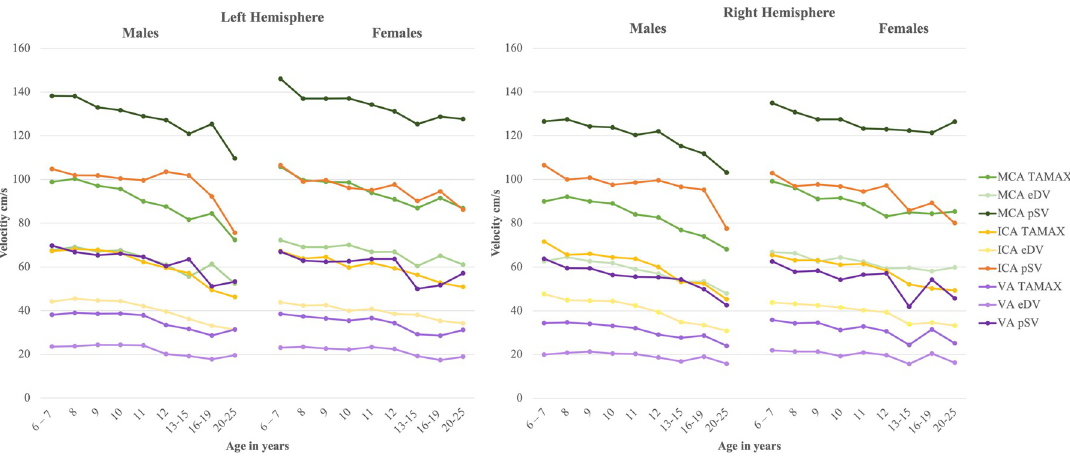
Fig 3. Velocities as a function of age, gender, blood vessel and hemisphere for males and females. MCA = middle cerebral artery; ICA = internal carotid artery; VA = vertebral artery; TAMAX = time-averaged maximum flow velocity; eDV = end-diastolic velocity; pSV = peak systolic